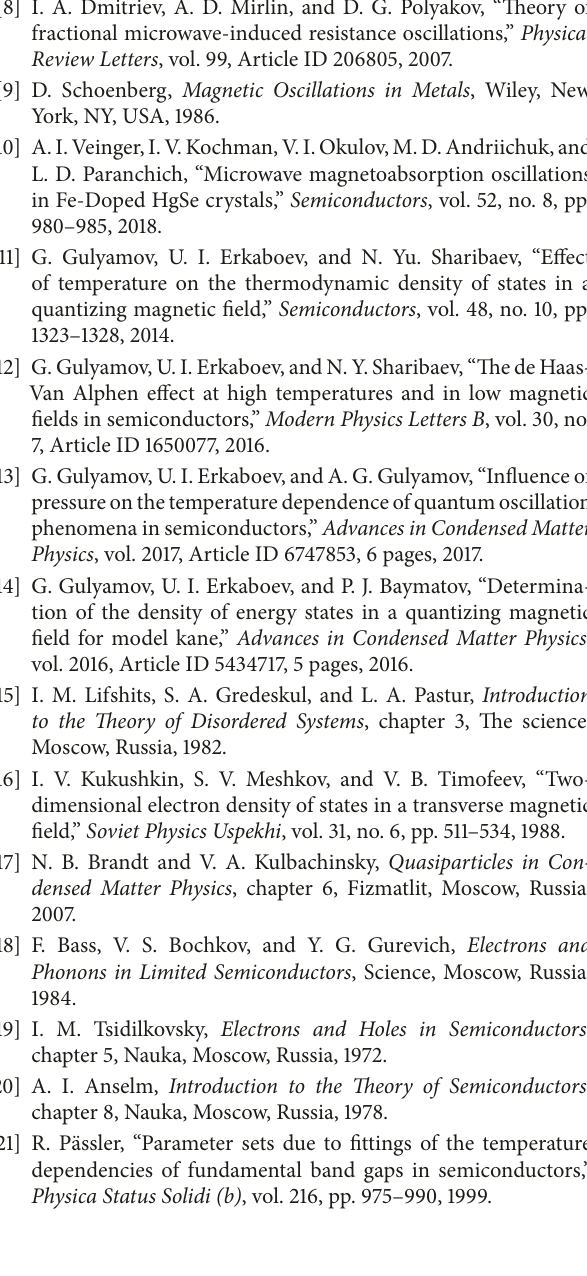
Figure 7: Influence of temperature on microwave magnetoabsorp- tion oscillations in HgSe. 1- T = 2.7 K, 2- T = 20 K, and 3- T = 100K.